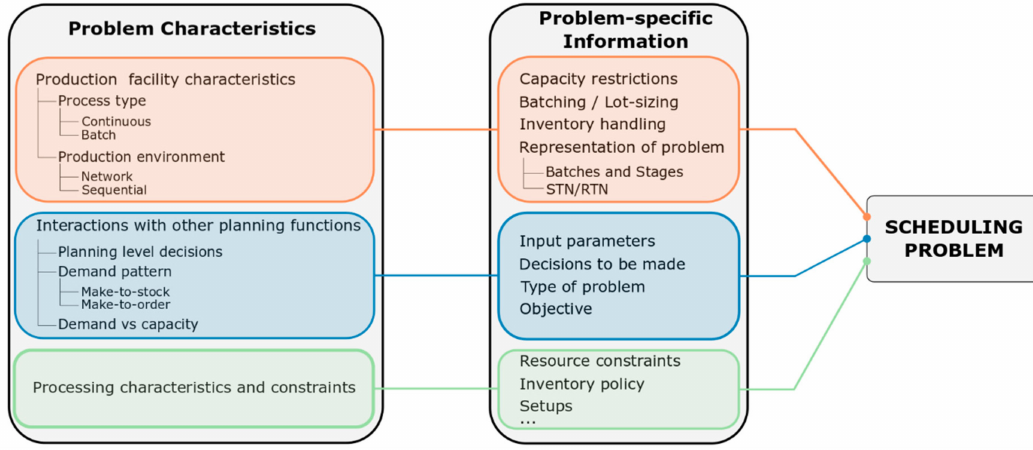
Figure 4. Information extracted from problem